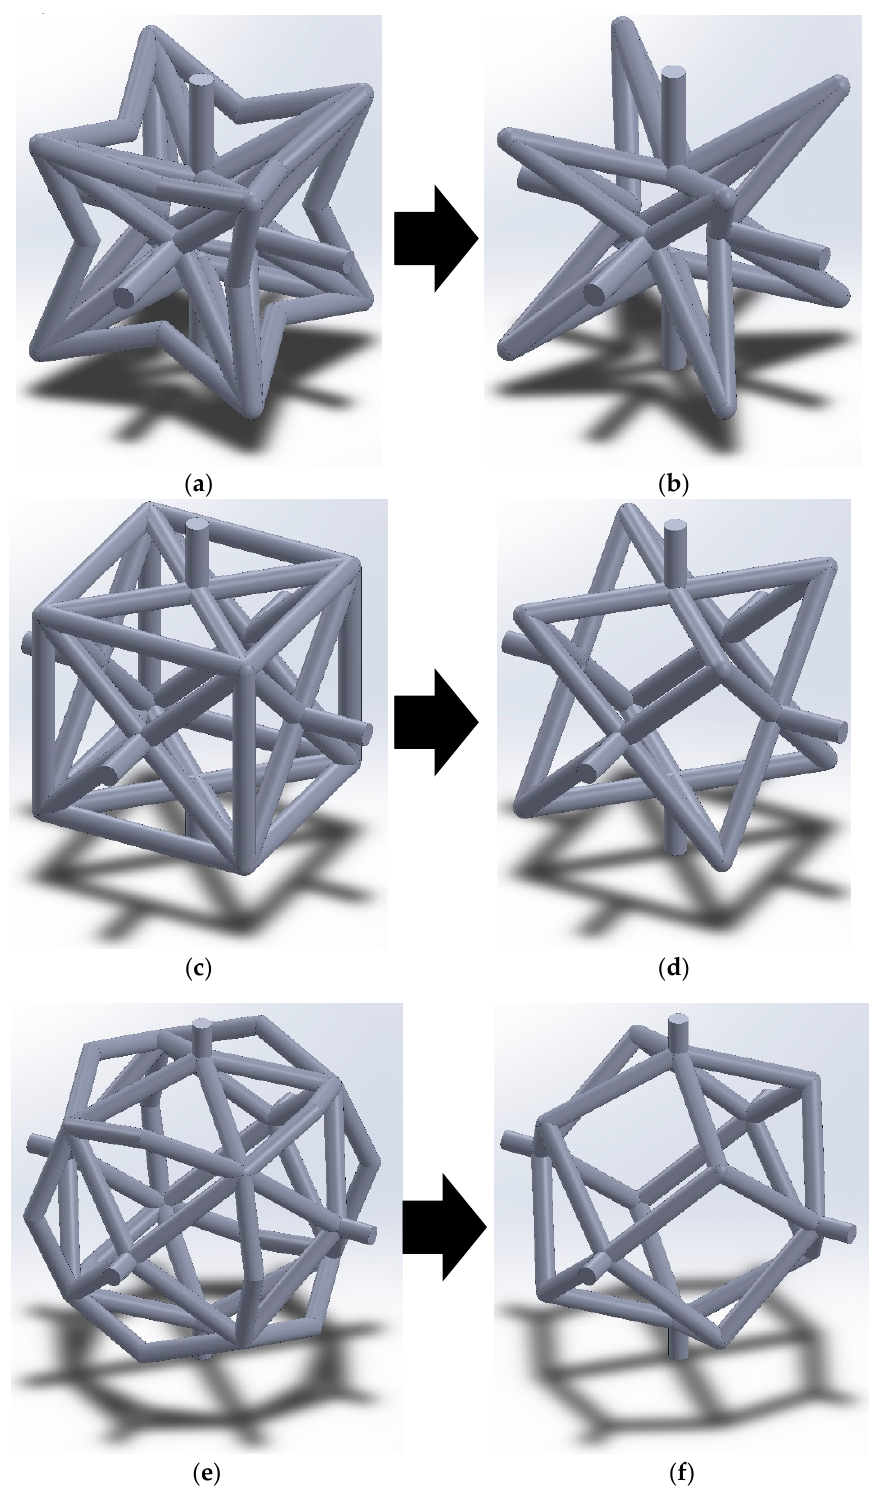
Figure 15. Generic geometry of the unit cell with positive (top), zero (middle), and negative (bottom) values of θ and ϕ for general unit cell (left column) and lightened unit cell (right column): ( a ) general re-entrant; ( b ) lightened re-entrant; ( c ) general zero Poisson’s ratio; ( d ) lightened zero Poisson’s ratio; ( e ) general convex; and ( f ) lightened convex unit cells.